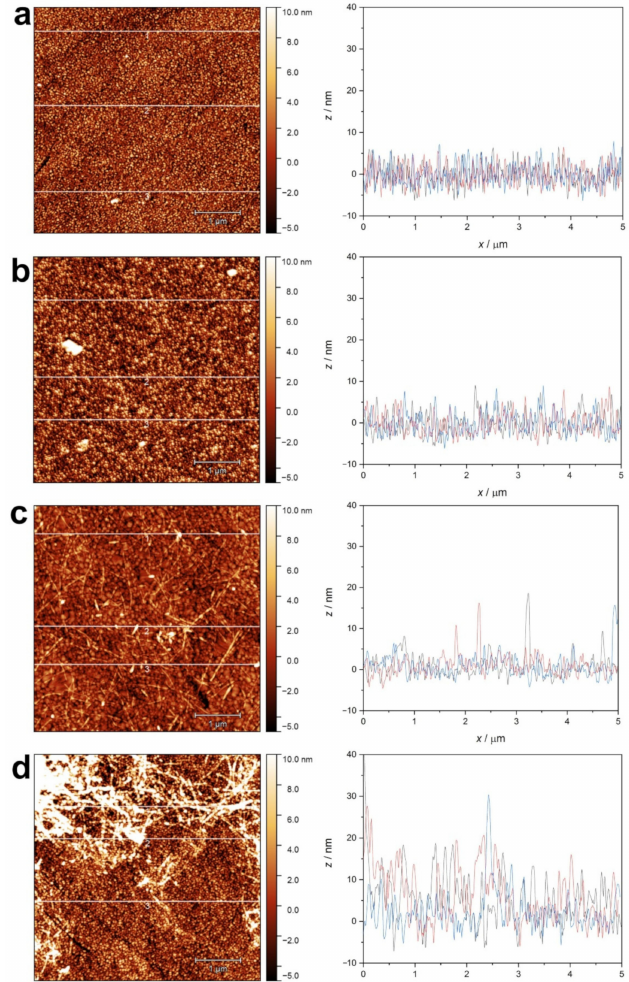
Figure 12. AFM topographic images of QCM sensor crystal surfaces after protein adsorption mea- surement. ( a ) native β -lactoglobulin at pH 2.0; ( b ) native β -lactoglobulin at pH 7.0; ( c ) β -lactoglobulin amyloid at pH 2.0; ( d ) β -lactoglobulin amyloid at pH 7.0. Line profiles at three selected positions (1 (black), 2 (red), 3 (blue)) are